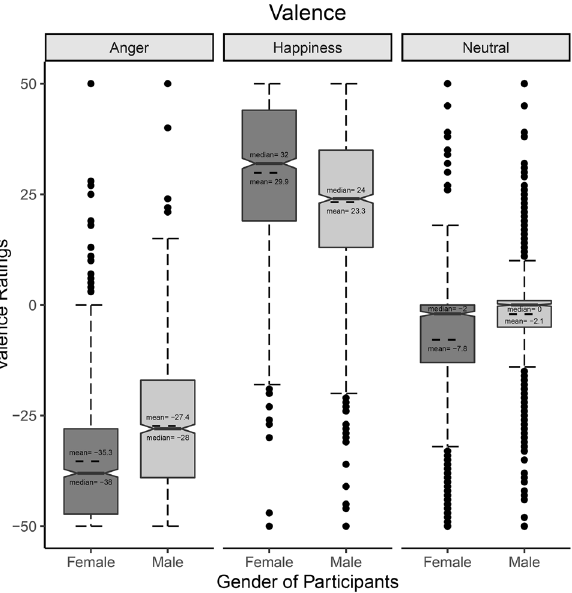
Figure 2. Valence: Emotion*Gender of participants’ interaction. Whisker box plot. All the differences are significant.